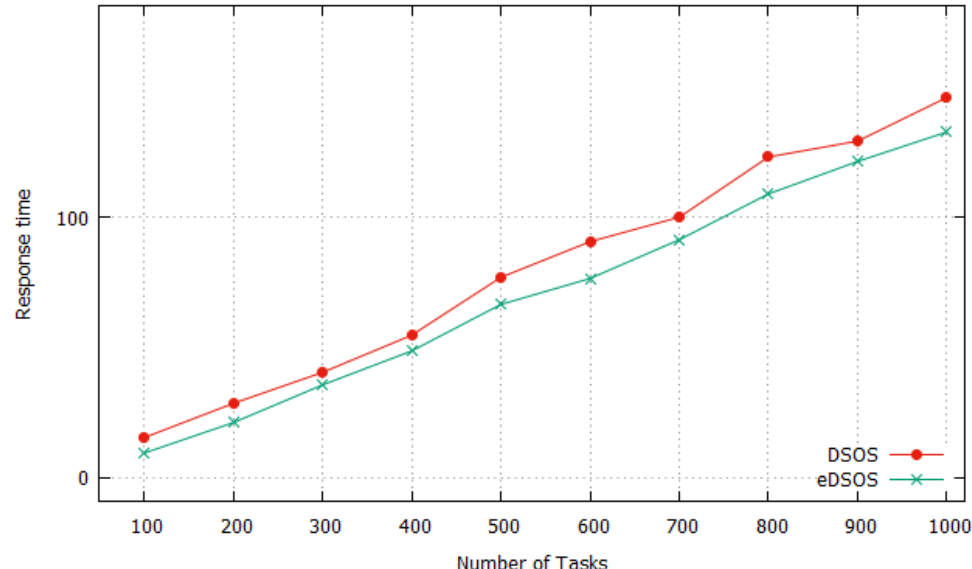
Figure 8. Response time for the dataset with the left-half distribution.